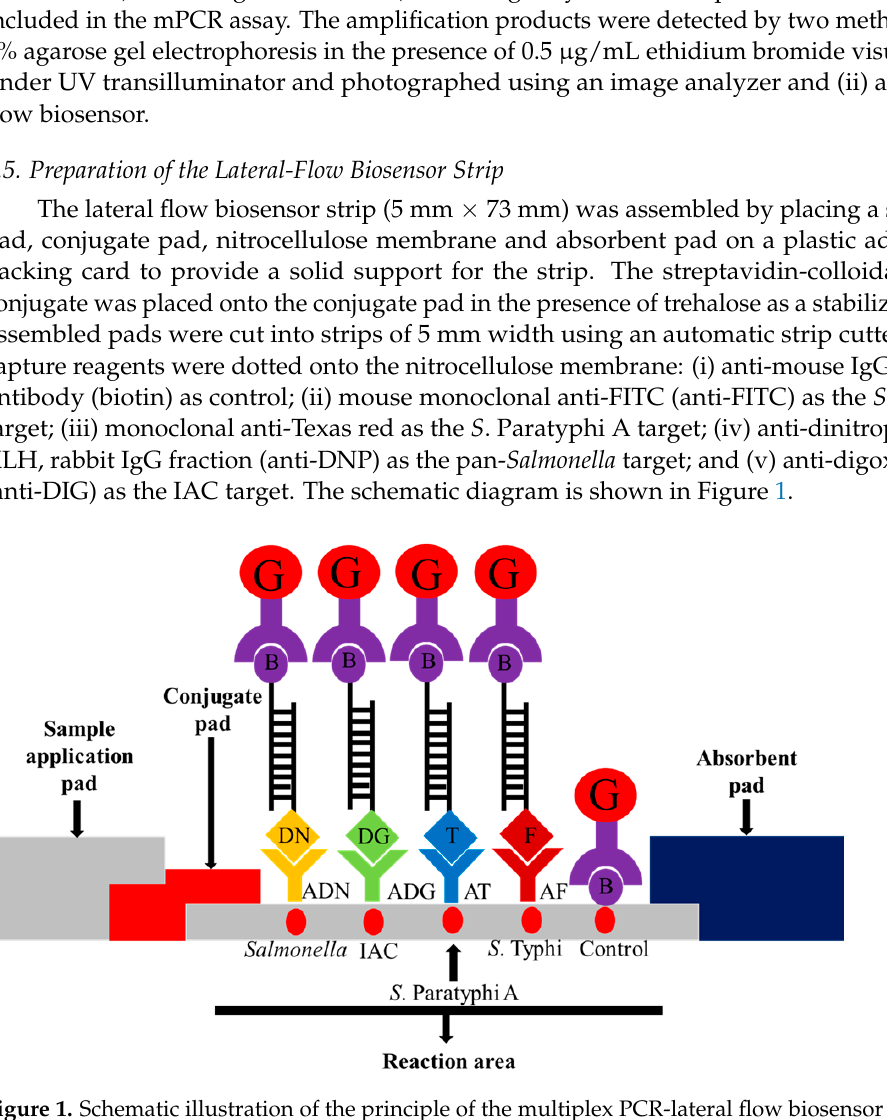
Figure 1. Schematic illustration of the principle of the multiplex PCR-lateral flow biosensor (mPCR- LFB) for the visualization of PCR amplicons using immobilized capture reagents on the nitrocellulose membrane. The target PCR amplicon for pan- Salmonella is dinitrophenyl and biotin labeled and is captured on the Salmonella reaction area; S. Paratyphi A is Texas red and biotin labeled and is captured on the S. Paratyphi A reaction area; S. Typhi is FITC and biotin labeled and is captured on the S. Typhi reaction area, and the internal amplification control (IAC) is digoxigenin and biotin labeled and is captured on the IAC reaction area. The accumulation of streptavidin-colloidal gold conjugate in the respective areas produced visible red dots. Excess streptavidin-colloidal gold conjugate is captured on the control reaction area for the validation of the lateral flow biosensor. G = streptavidin-colloidal gold conjugate; B = biotin; DN = dinitrophenyl; ADN = anti-dinitrophenyl; DG = digoxigenin; ADG = anti-digoxigenin; T = Texas red; AT = anti-Texas red; and F = FITC; AF =